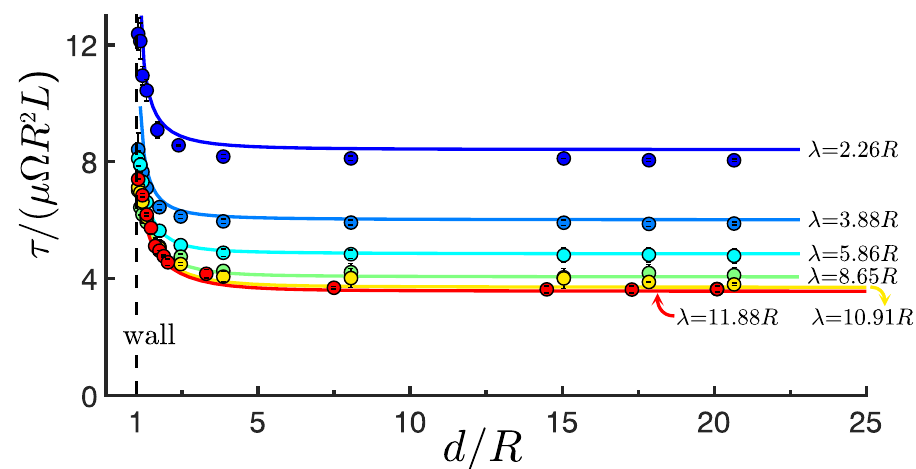
Figure 9. Dimensionless torque τ for different helical wavelengths ( λ / R ) versus boundary distance ( d / R ) scaled by the helical radius R . The optimized MIRS simulations are the solid curves and the experimental values are solid circles with vertical error bars. The data also show good agreement for the far from boundary value at d / R ≈ 20 (see Figure 8). The data show that once the far from boundary distance was properly calibrated, the MIRS worked very well to represent the effects of the